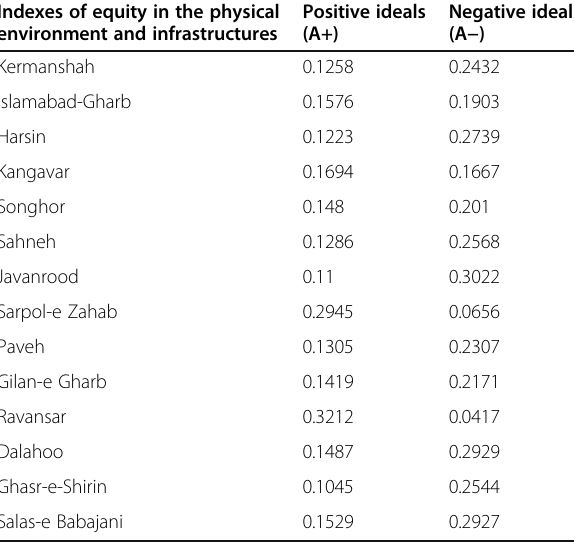
Table 6 Distance from the positive and negative ideals Indexes of equity in the physical environment and infrastructures